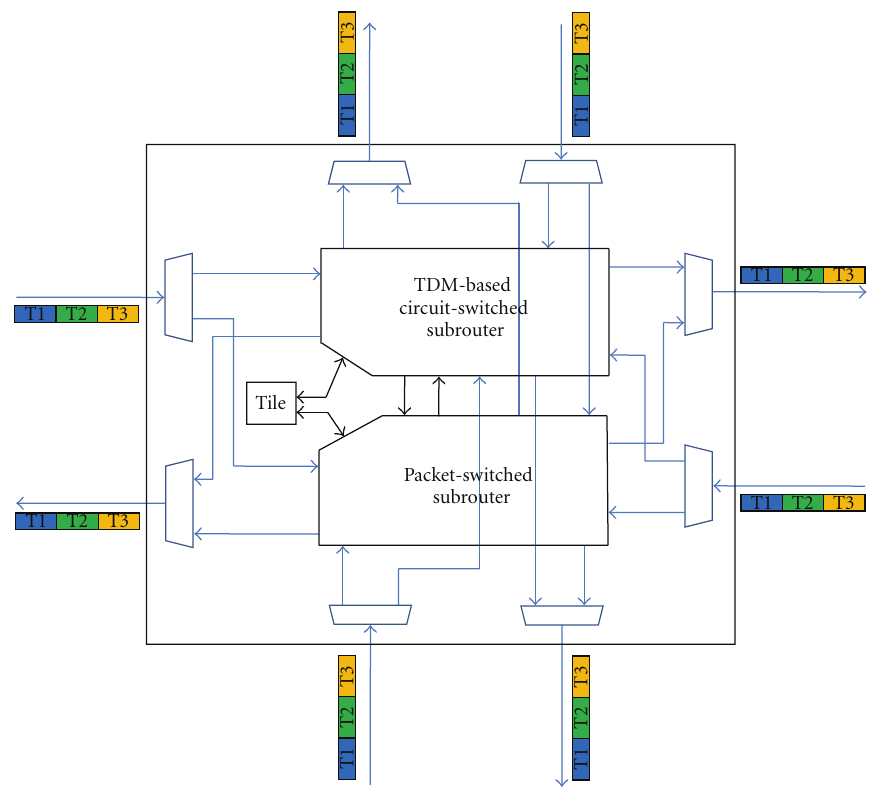
Figure 3: Hybrid TDM-based router